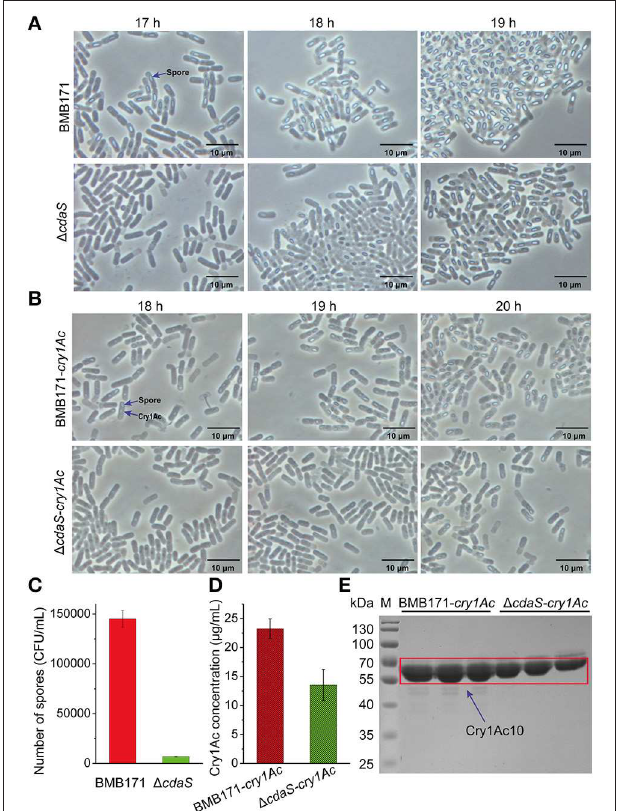
FIGURE 6 | Effect of cdaS deletion mutation on sporulation and parasporal crystal formation. Time courses of the sporulation in BMB171 vs. 1 cdaS (A) and parasporal crystal formation in BMB171- cry1Ac vs. 1 cdaS - cry1Ac (B) . Strains were grown in GYS medium at 28 ◦ C and 200rpm. Spore formation and parasporal crystal formation were monitored by phase-contrast microscopy at the indicated times. To test spore formation, 1mL GYS culture samples at 18h were heated at 80 ◦ C for 10min, diluted in sterile water, and tested for colony formation on LB plates (C) . The concentrations of Cry1Ac10 at 19h were measured by the Bradford method (D) and analyzed by SDS-PAGE (E) . Data are represented as the mean of three independent experiments (error bar: SEM). A two-tailed t -test was used for statistical analysis.